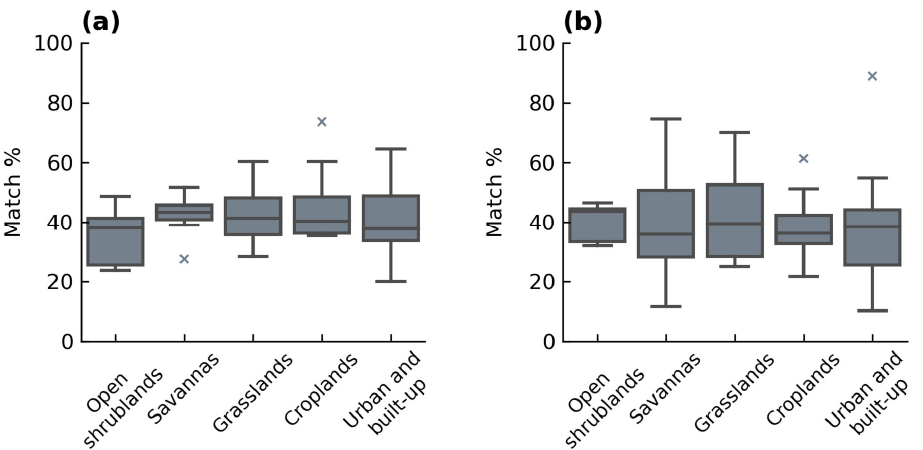
Figure 5. As in Figure 4, during nighttime.